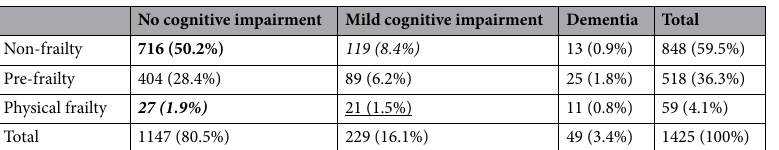
Table 4 summarizes the SVD features for each of the four groups revealed by MRI. Compared to nci-PF group participants, CF group participants exhibited higher white matter hypointensity 21 volumes (beta = 9.37, SE = 3.84, p = 0.015), higher periventricular hyperintensity (PVH) grades (beta = 0.89, SE = 0.41, p = 0.029), and higher deep and subcortical white matter hyperintensity (DSWMH) grades (beta = 1.04,